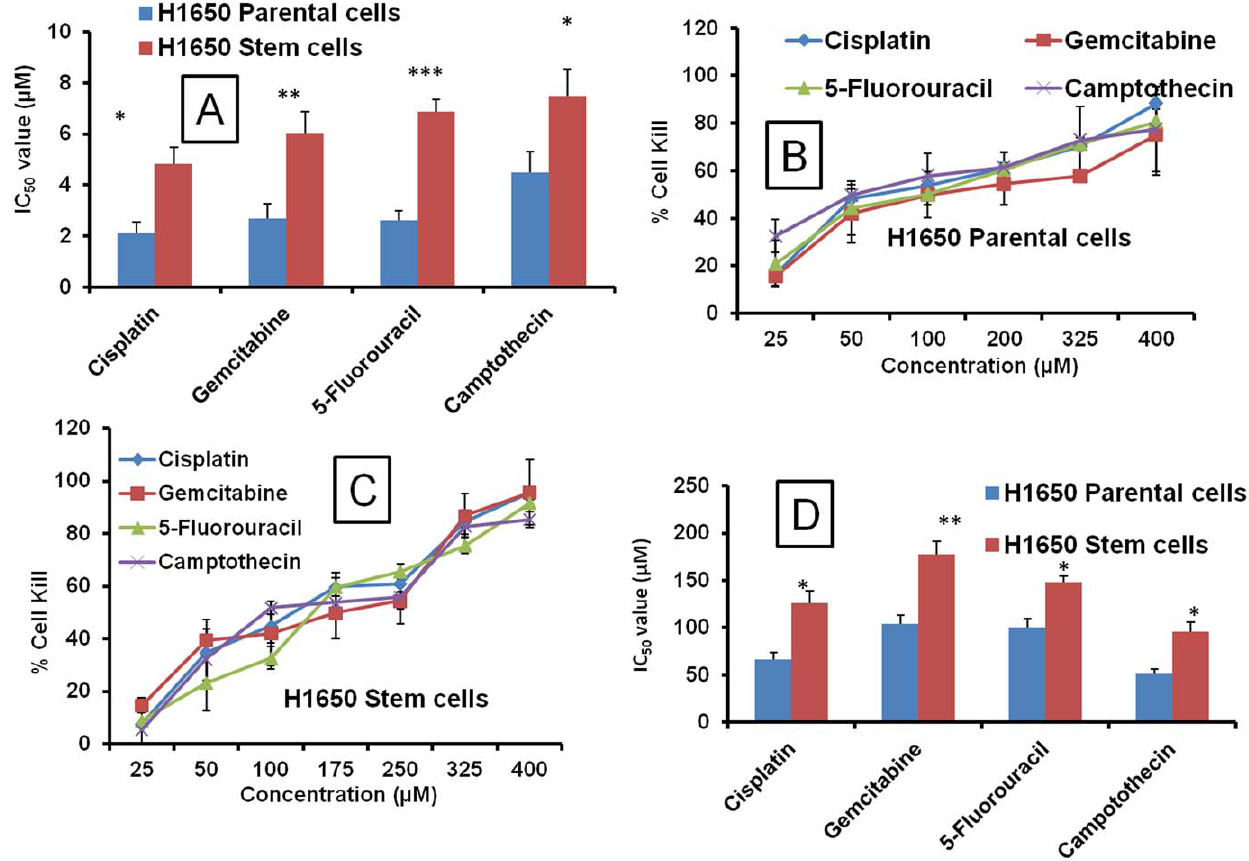
Figure 5. Comparative IC 50 values of various anticancer drugs in 2D and 3D culture system. A) Cytotoxicity of various anticancer drugs (Cisplatin, Gemcitabine, 5-Fluorouracil and Camptothecin) in 2D H1650 parental and stem cells. B) Cytotoxicity of various anticancer drugs in 3D alginate scaffold systems on H1650 parental, C) H1650 stem cells. D) Comparative cytotoxicity IC 50 values of various anticancer drugs in 3D alginate scaffold systems on H1650 parental and stem cells. Each data point is represented as mean 6 sem (n=4–6). * , 0.05, **P , 0.01 and ***P , 0.001 Vs respective H1650 parental cell groups.